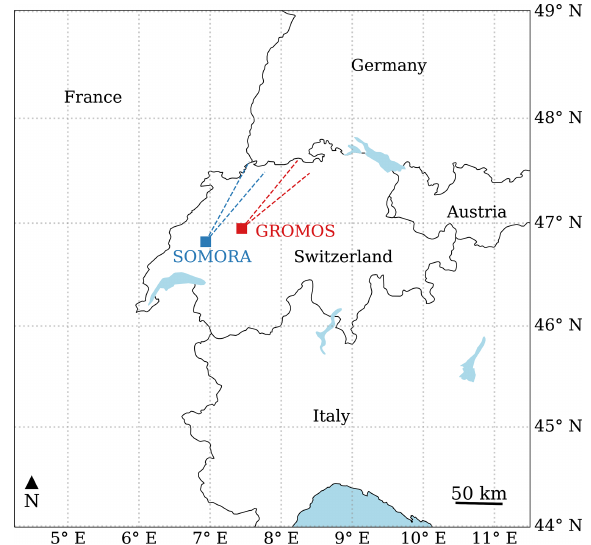
Figure 1. Location of GROMOS and SOMORA, with their approx- imate viewing